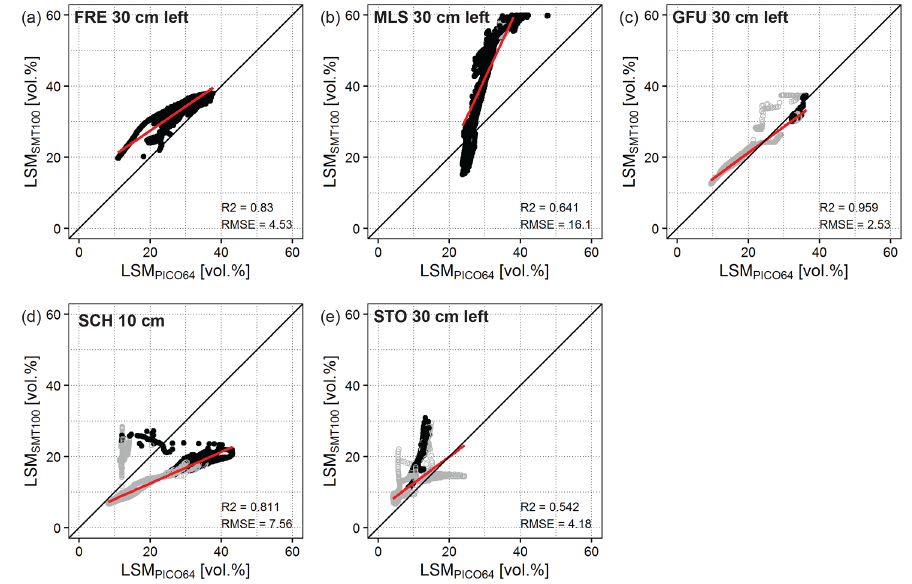
Figure 5. Comparison between PICO64-measured ( x axis) and SMT100-measured LSM ( y axis) at all sites. The linear relation is used for the SMT100 calibration. The hollow grey points at GFU, SCH and STO represent measurements taken when the ground temperature was below 1 ◦